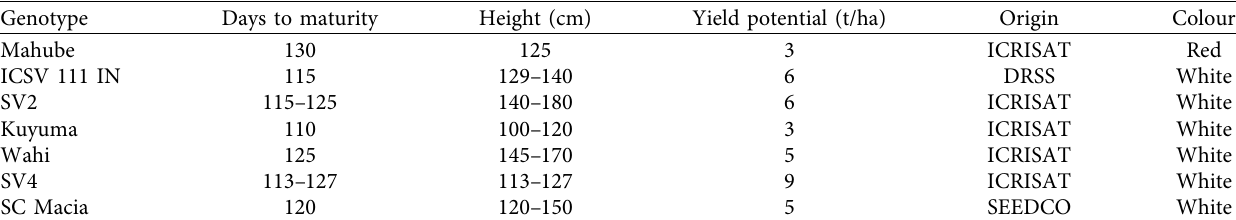
Table 1: Sorghum genotypes used in the in vitro